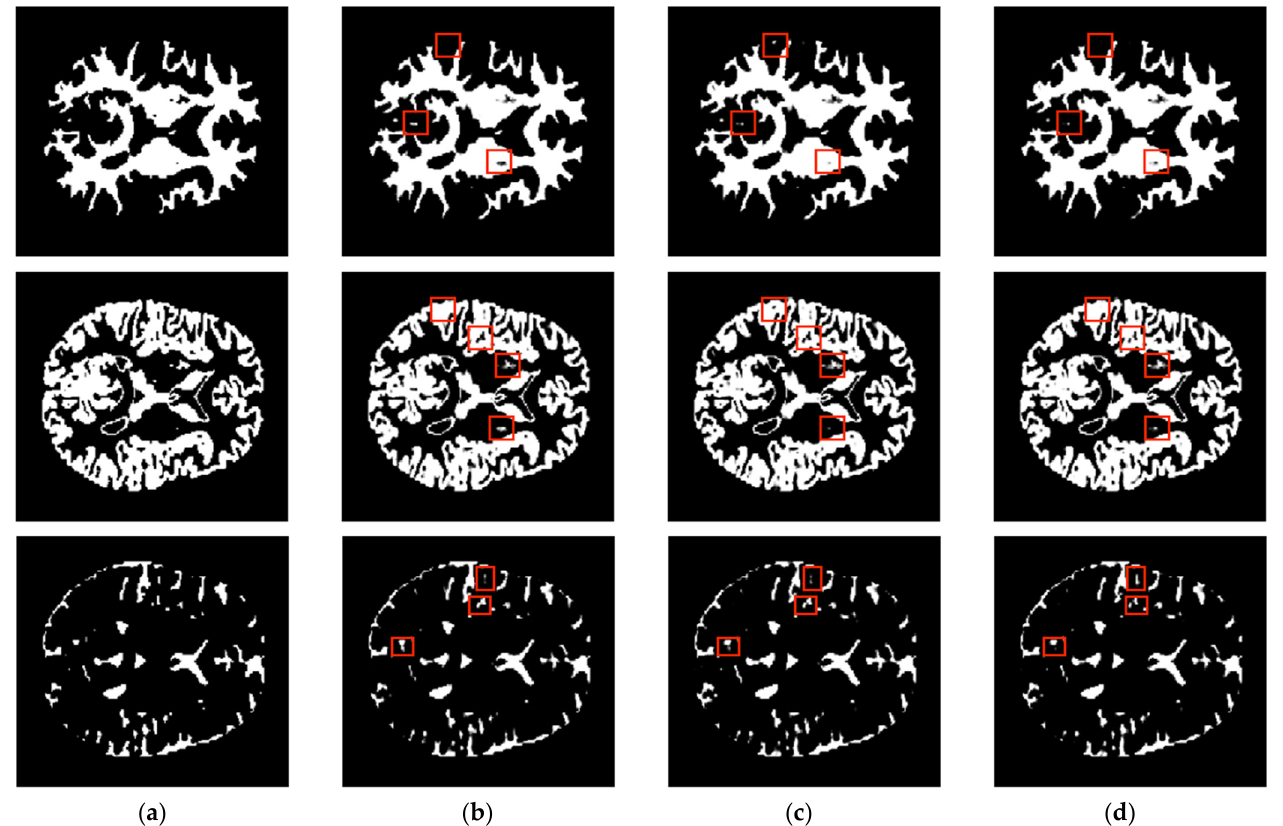
Figure 7. Illustration of segmentation results for axial plane for existing methods and SIP-UNet for WM, GM, and CSF (top to bottom): ( a ) ground truth (binary map), segmented binary maps generated by ( b ) single-slice input UNet, ( c ) multi-slice input UNet, and ( d ) proposed SIP-UNet.